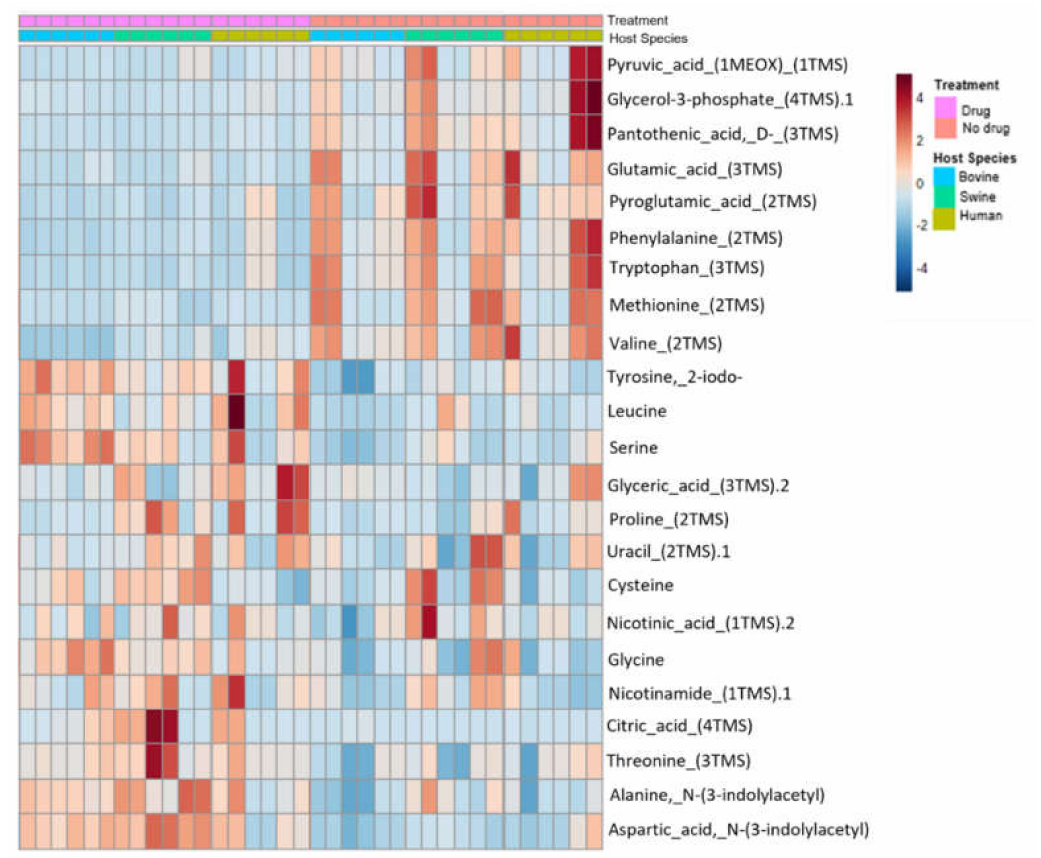
Figure 2. Heatmap derived from two–way ANOVA showing clustering of metabolite concentrations based on drug